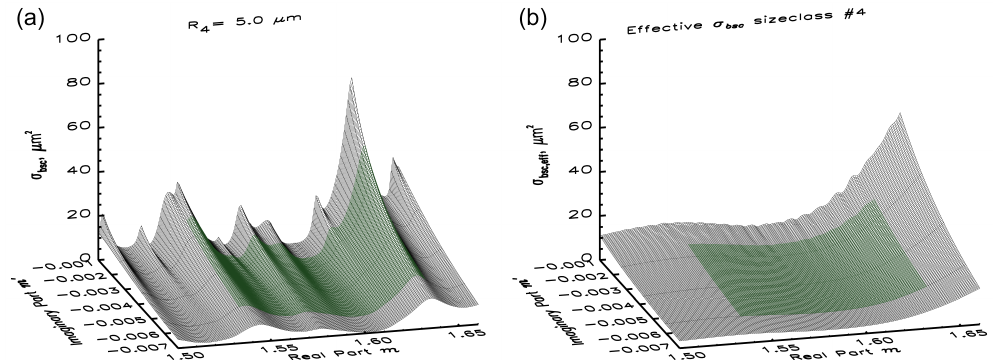
Figure 5. The same as Fig. 4 but for the backscatter cross section σ bsc (a) and the effective backscatter cross section σ bsc (b) . The backscatter cross section is very sensitive to the refractive index. While the major fraction of backscatter cross section variations can be removed by calculating the effective backscatter cross section, the sensitivity at the extreme end of the defined refractive index